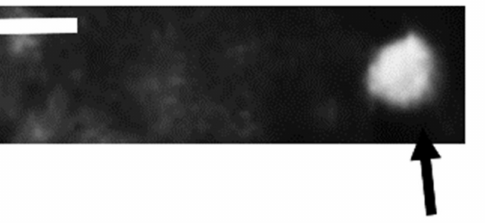
Figure 6. Scanning electromicrograph showing the spherical shape of biogenic nanosilver particles (denoted by black arrow) (Scale bar 100